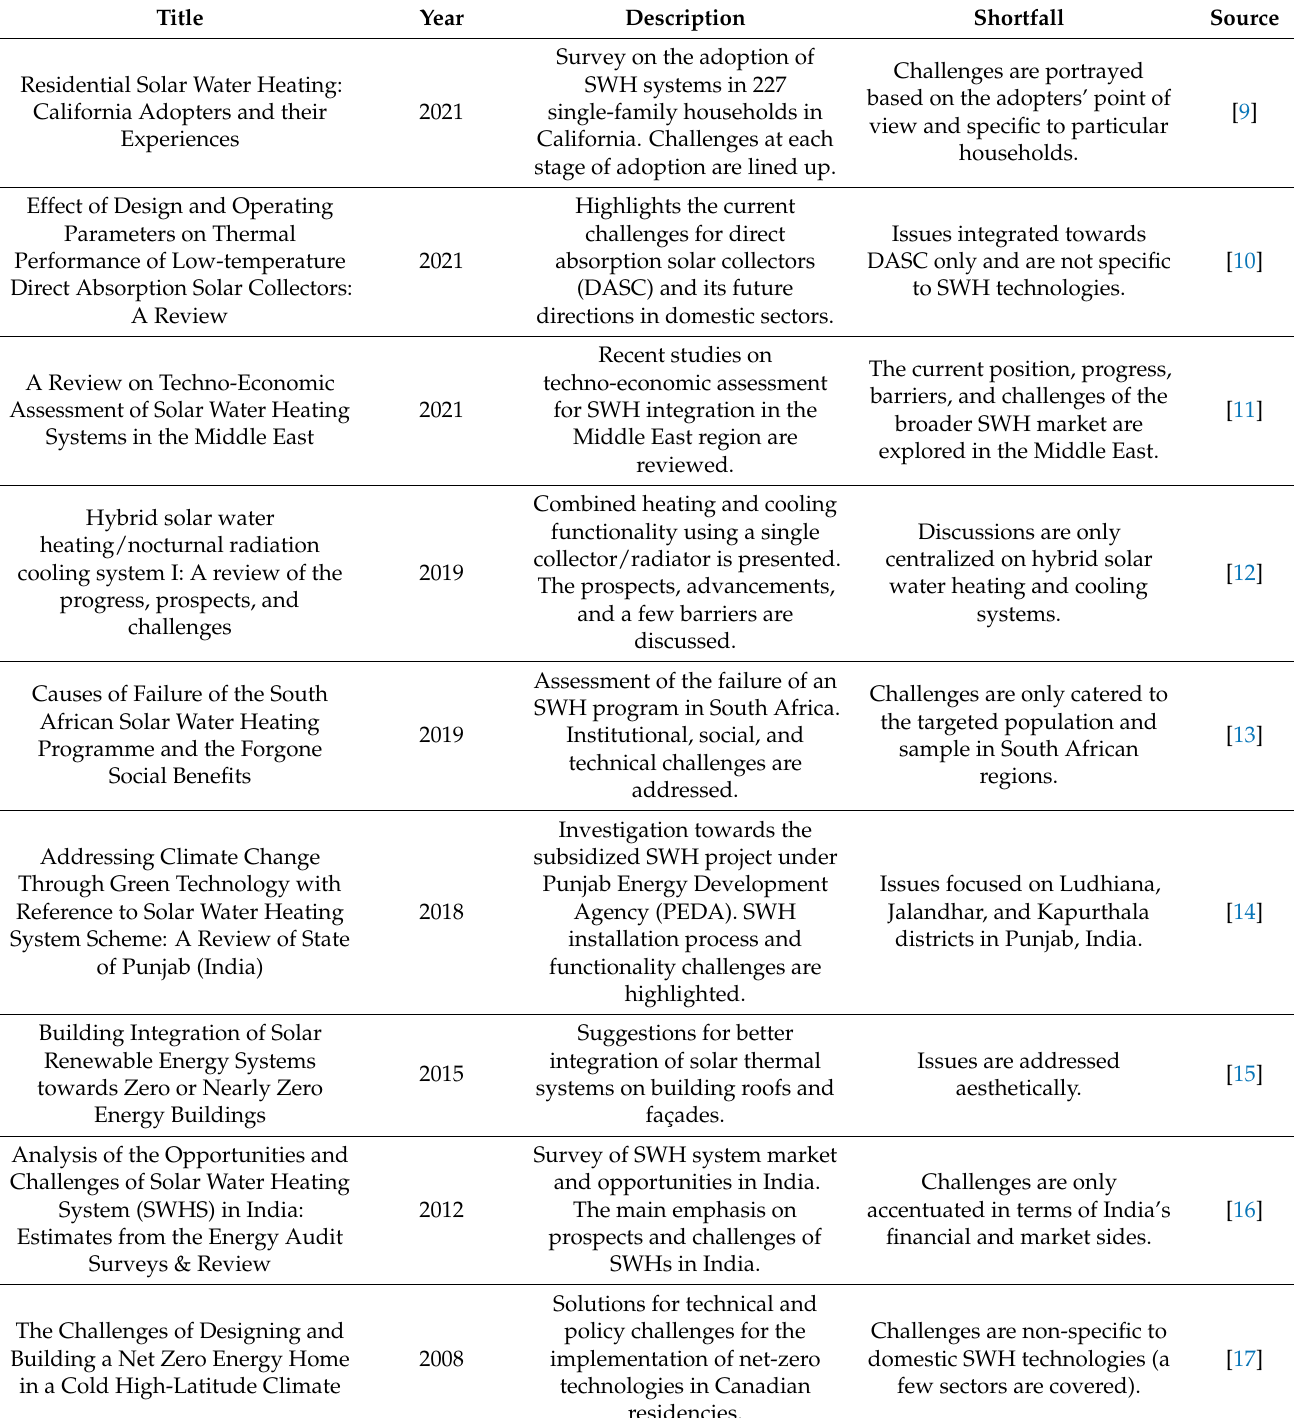
Table 1. Previously conducted studies and reviews on solar water heating